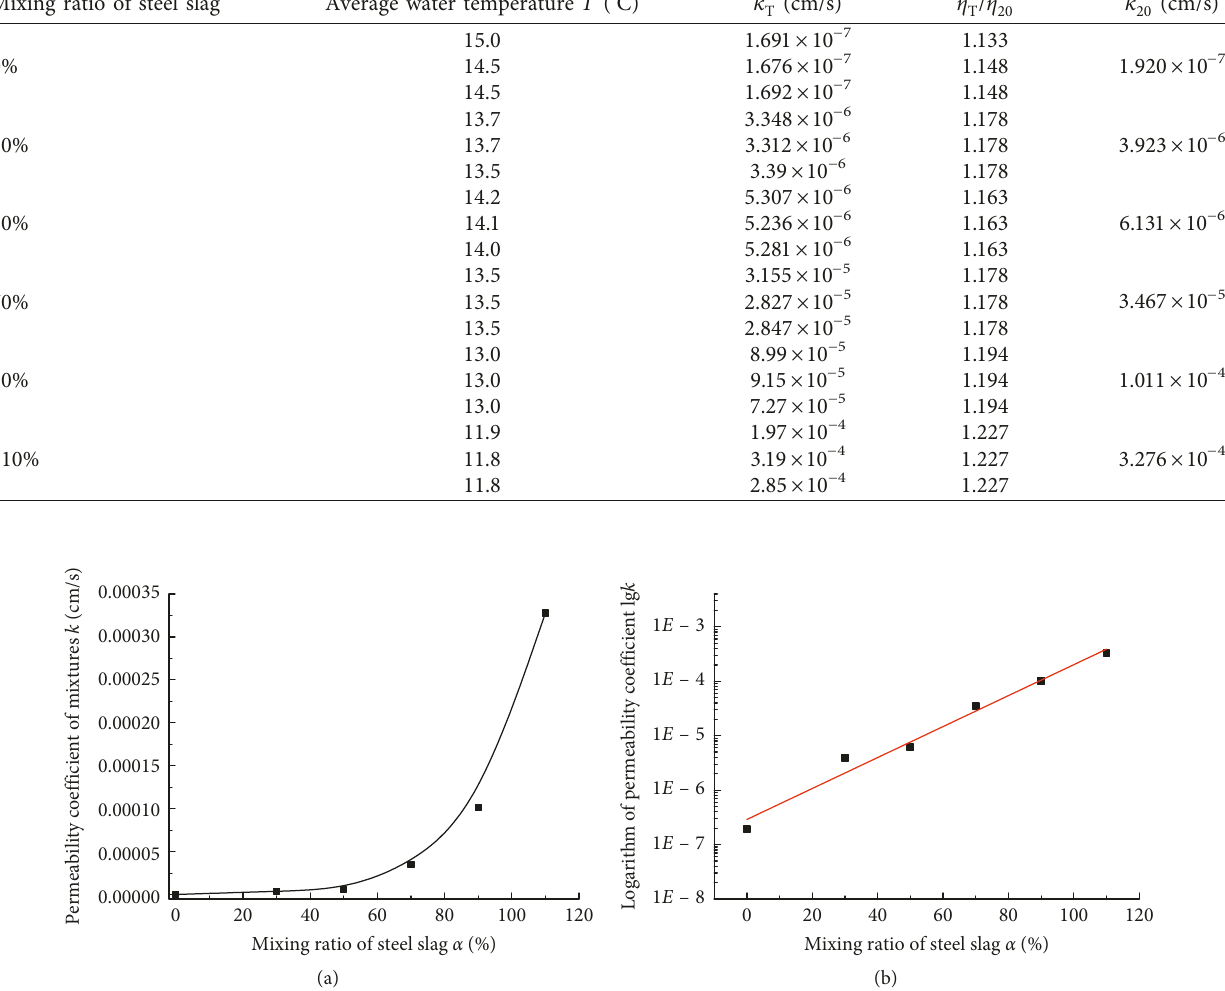
Table 9: Permeability coefficient of modified silt with different amounts of steel slag.